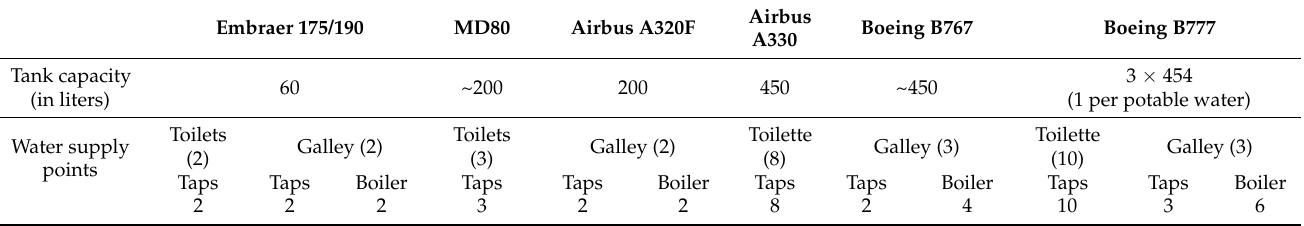
Table 1. Water supply points according to aircraft type and frequency and sanitization methods applied in the investigated aircraft compared to those recommended by the aircraft